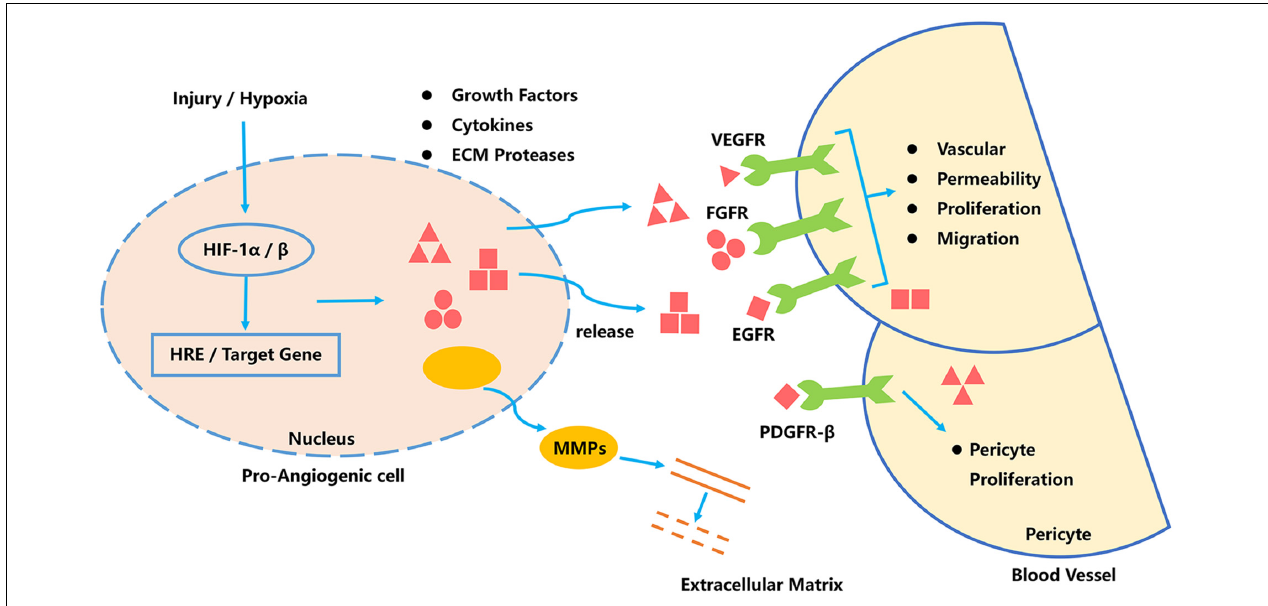
FIGURE 2 | Signaling pathways of tumor angiogenesis.